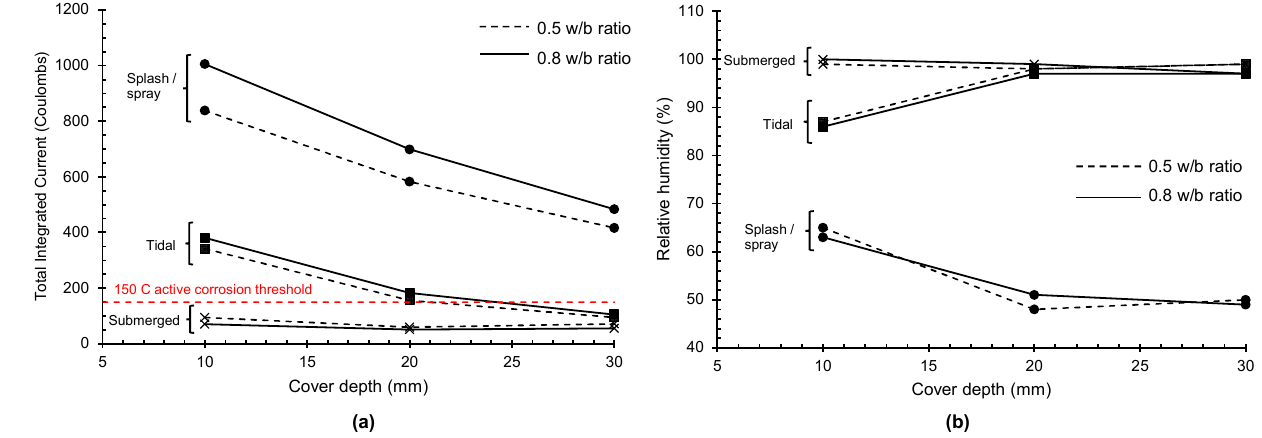
Figure 8. Total integrated current ( a ) and relative humidity profiles ( b ) at various cover depths for specimens in the simulated exposure zones .